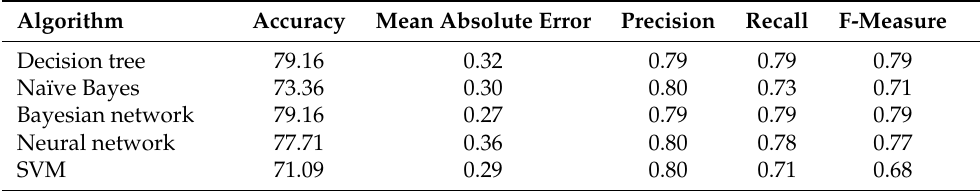
Table 12. LOC and readability metrics results for summation division approach using percentage